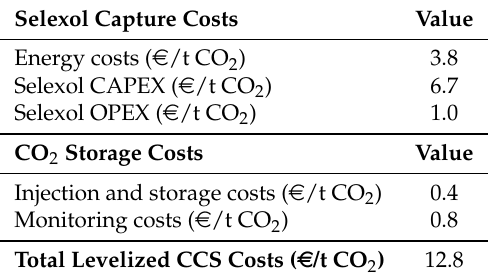
Table 9. Levelized costs (reference scenario, electricity generation set-up) for onshore Selexol capture, injection, storage and monitoring considering CO 2 emissions of 2.2 t/t